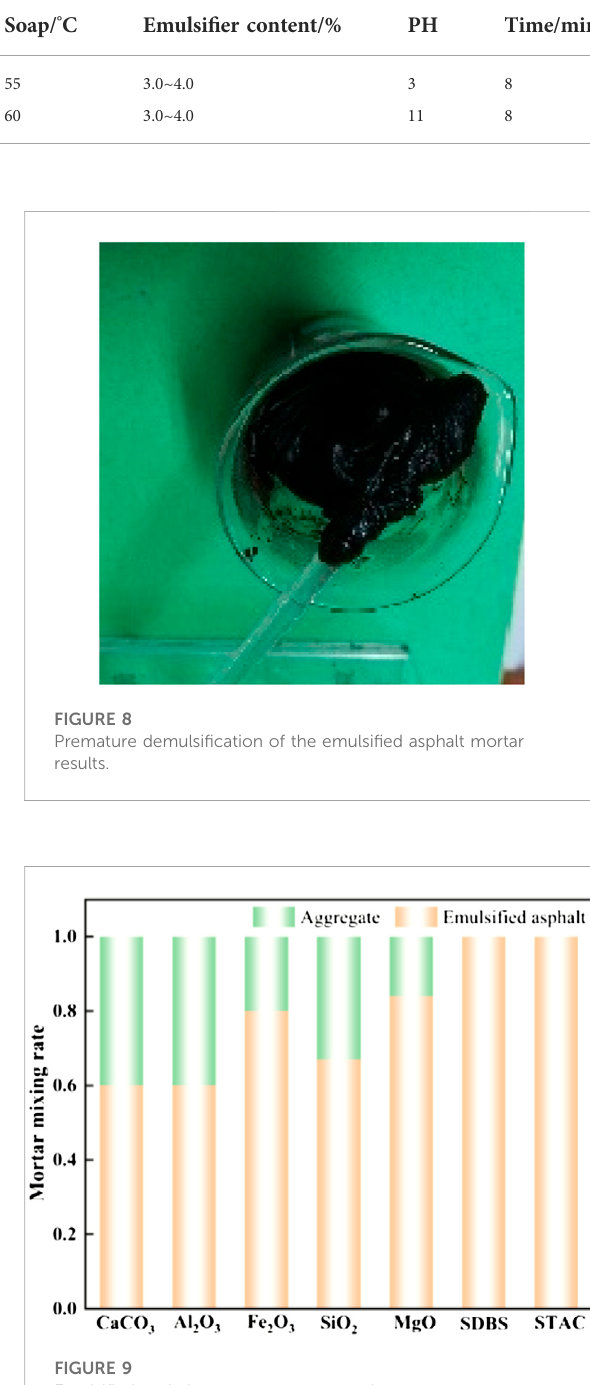
FIGURE 9 Emulsi fi ed asphalt-aggregate mortar